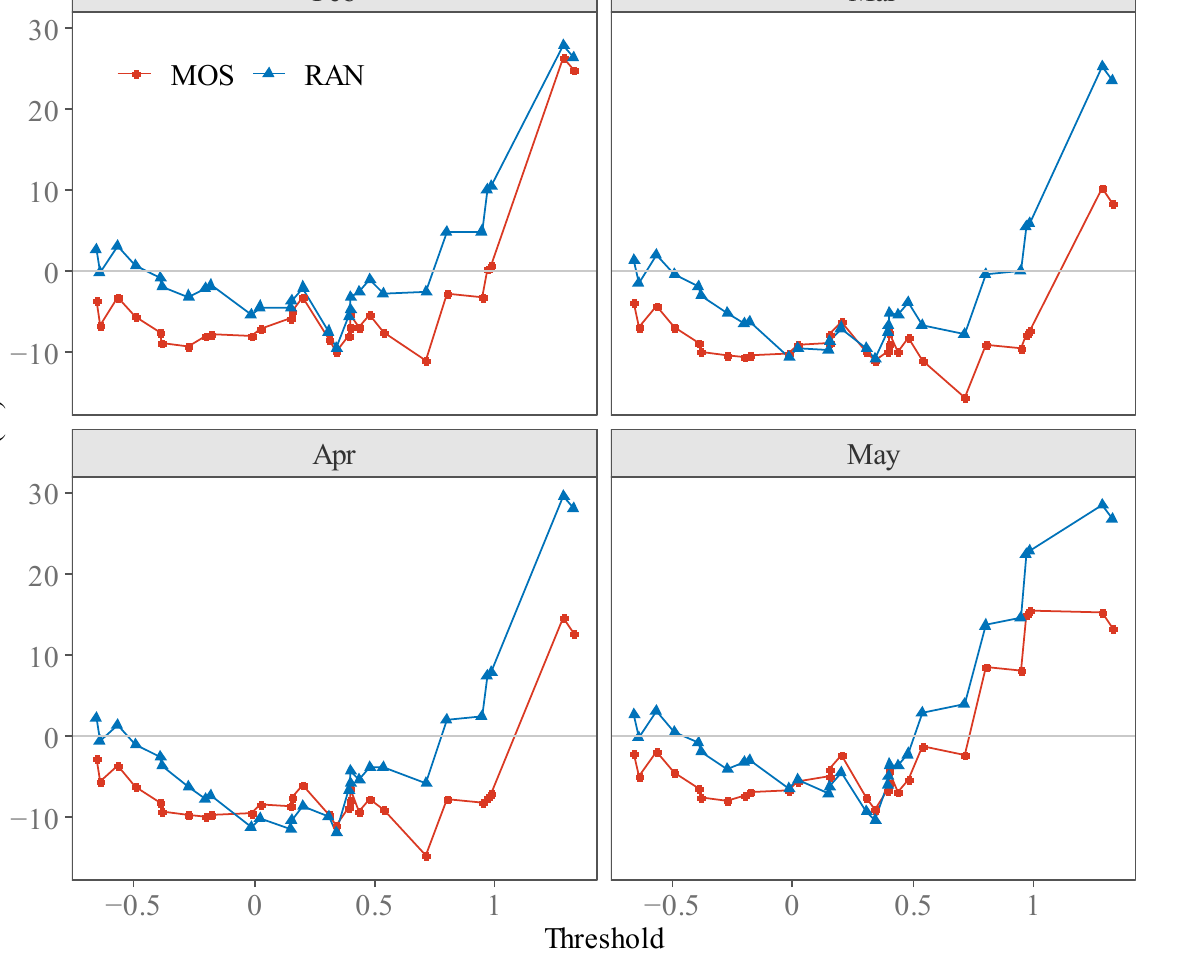
Figure 10. BSS by the MOS approach and the RAN approach for the YRSRI corresponding to four releasing months of CFSv2.